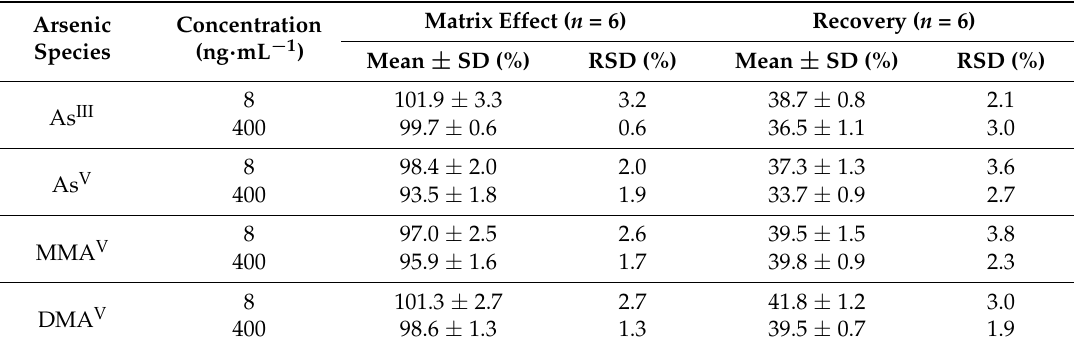
Table 2. Matrix effects and recovery rates for the four analytes in cynomolgus macaque plasma.